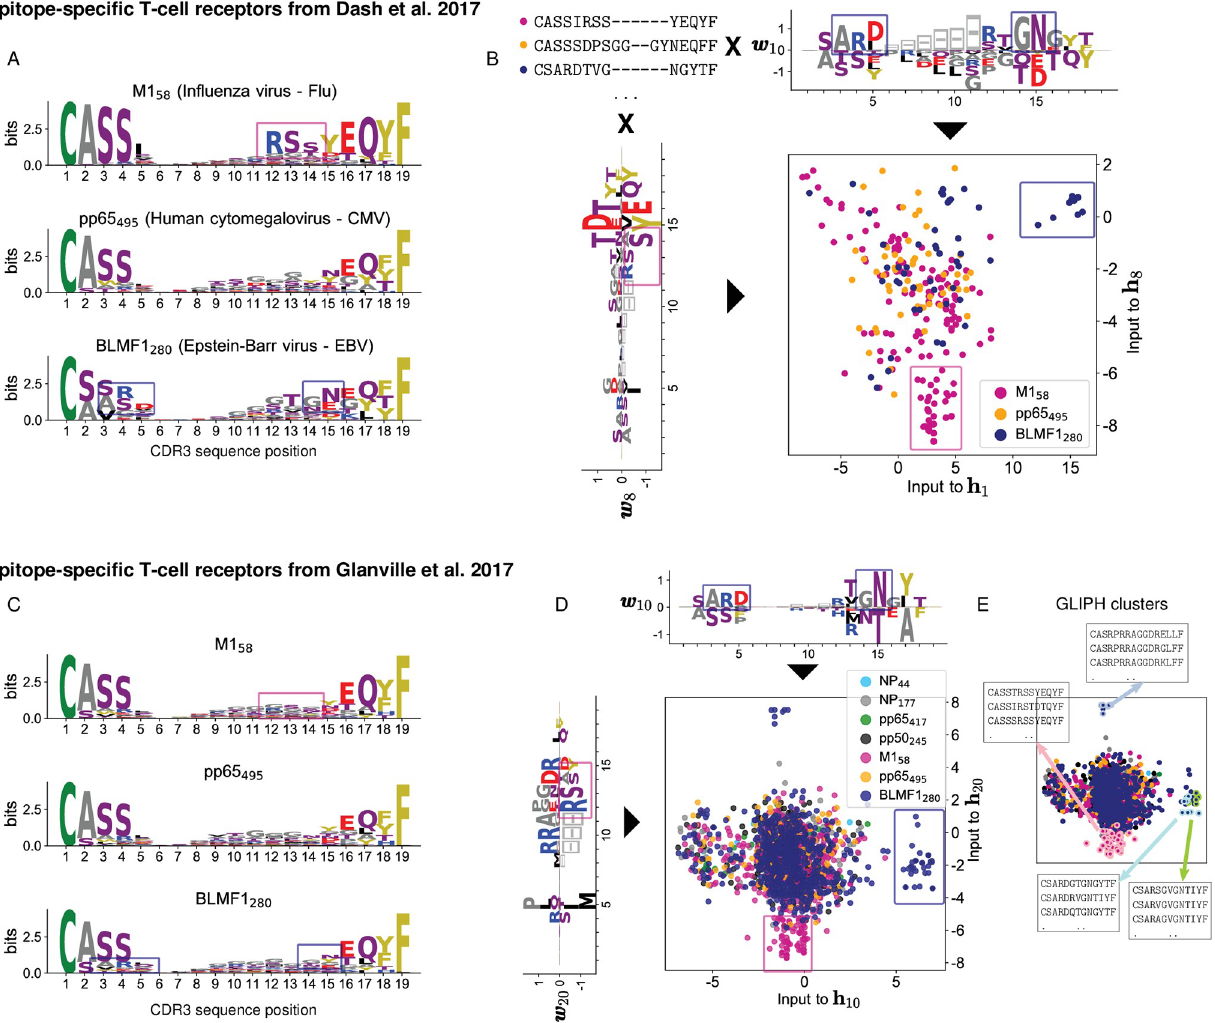
Fig 6. RBM retrieves TRB sequence motifs reported in Dash et al. 2017 [17] and Glanville et al. 2017 [22]. A: Sequence logos of aligned CDR3 of each human TCR repertoire specific to CMV, EBV and Flu epitopes based on the tetramer sorted data from Ref. [17]. Sequence motifs identified in Ref. [17] are marked by colored boxes. The sequence motifs visualized here from aligned CDR3 are similar but not exactly the same as the ones in Ref. [17]. B: We learned an RBM on the full list of CDR3 sequences from the three repertoires in A. The learned weights show the same sequence motifs as in A and the inputs to the corresponding hidden units identify two groups of clones: one specific to the M1 58 epitope (magenta dots) and the other to the BMLF1 280 epitope (blue dots). C-D: Same representation as in A-B for the tetramer sorted data from Ref. [22] and the RBM trained on them. For the sake of comparison we have limited the logos in C to the same epitopes as in A. The pp65 495 repertoires (orange dots both in B and D) is the most heterogeneous (see Fig 7A) and the characteristic sequence motifs reported in [17, 22] are not easily visible in A-C (see instead S7A–S7C Fig). In both cases, the RBM is able to learn a set of weights reflecting such motifs, see S7A–S7D Fig. E: Same as D, but where T-cell clones belonging to 4 of the 35 clusters found by GLIPH in [22] are circled in color. These clones are well separated in RBM space. The RBM representation space captures the similarity of sequences that have the same epitope specificity but are placed into different clusters by GLIPH (blue- and green-circled clusters).